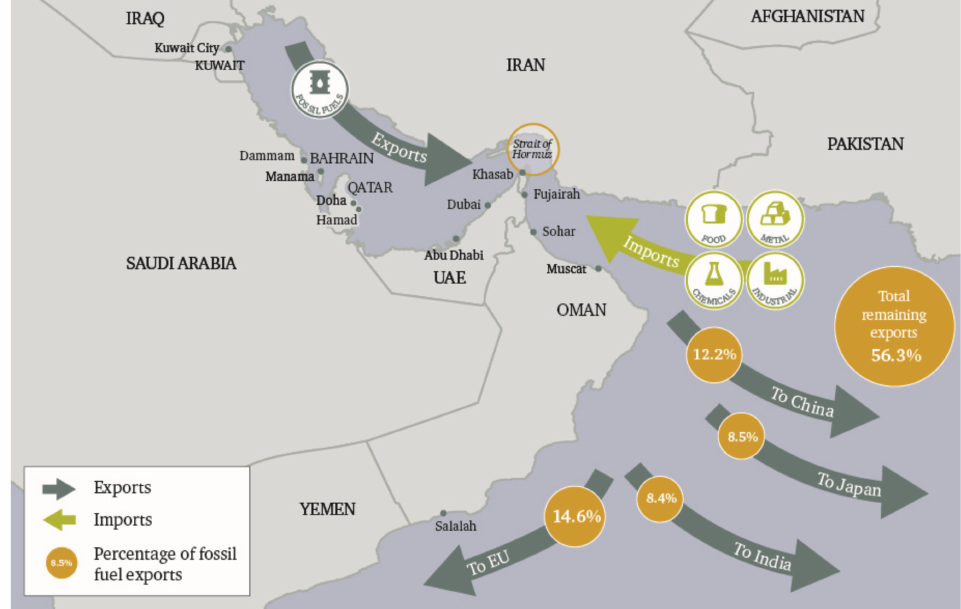
Figure 5. Major Gulf Cooperation Council Ports and the Strait of Hormuz Trade Flows. Source: